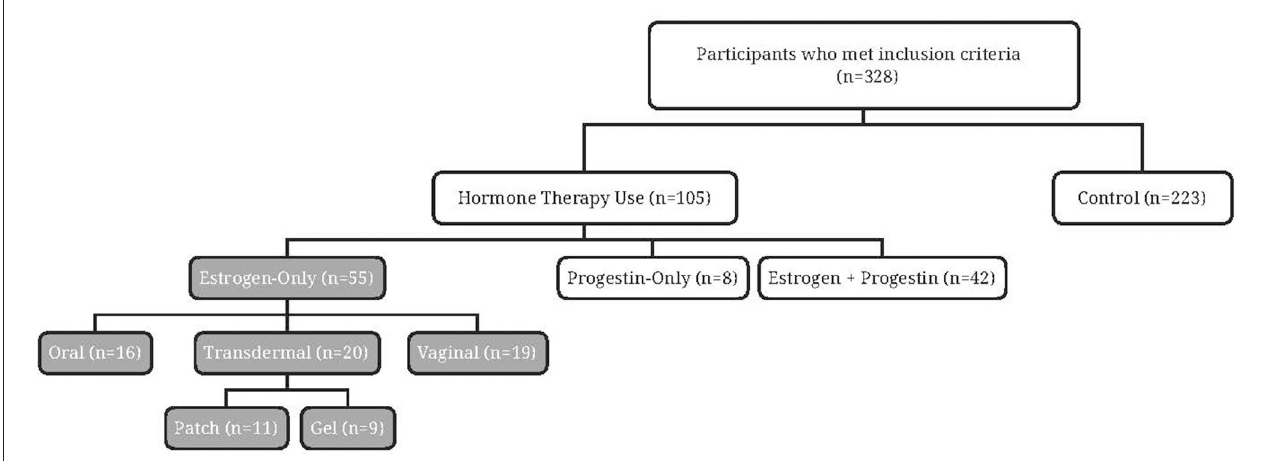
FIGURE 1 | Flow diagram of study